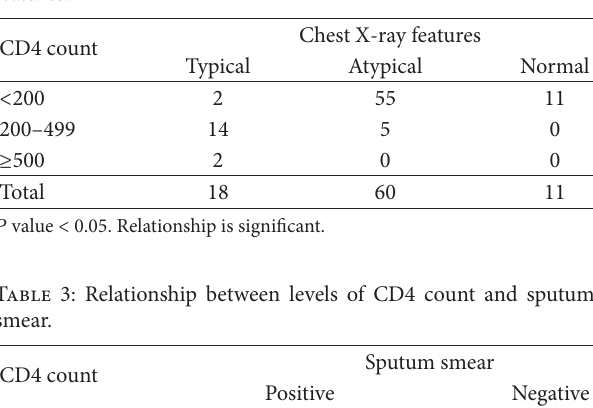
T 2: Relationship between levels of CD4 count and chest X-ray features. Chest X-ray features Typical Atypical